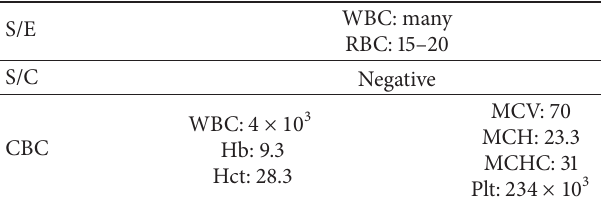
Table 1: Results of first test in case 1. Table 2: Results test in case 2.